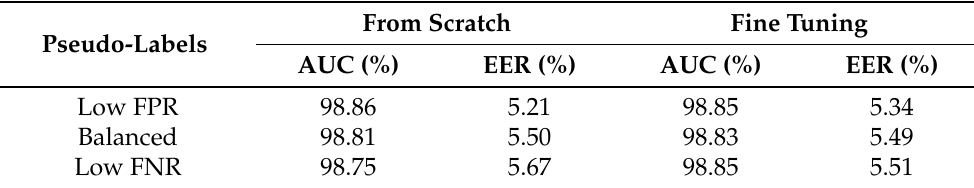
Table 8. AUC (%) and EER (%) for FS02 development partition using pseudo-label domain transfer setup training a new neural network from scratch and fine tuning the best performing model adapted using Log Deep CORAL